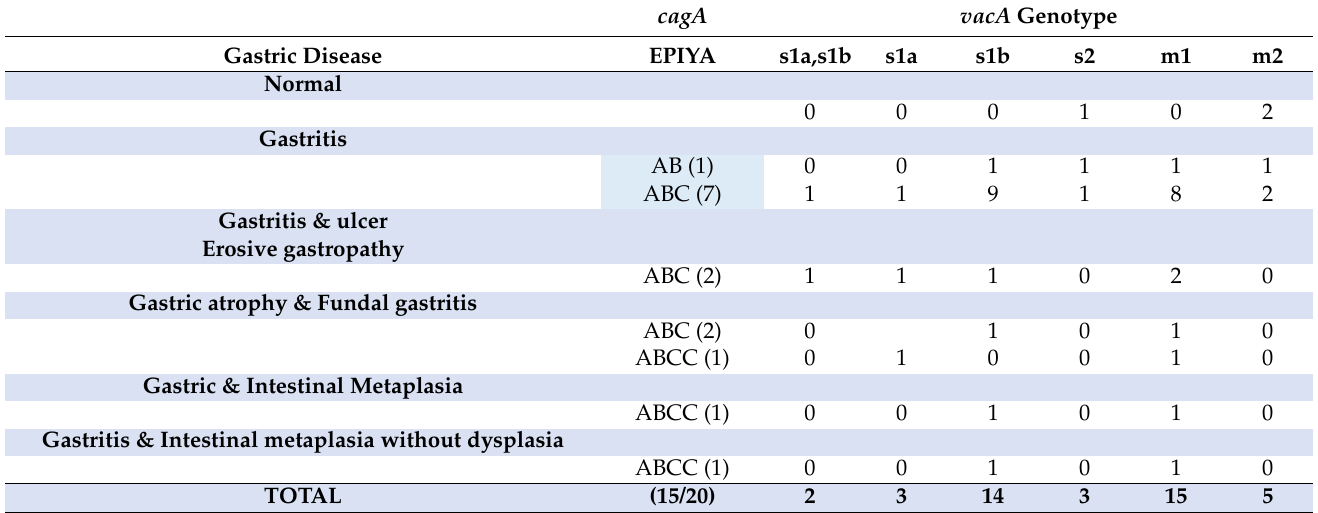
Table 3. Gastric findings and scores in Navajo patients and their association with H. pylori vacA and cagA genotypes. cagA vacA